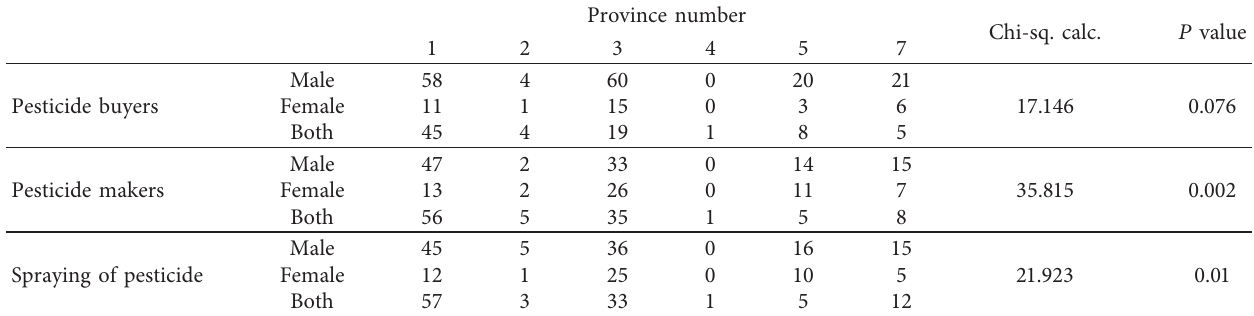
Table 5: Gender role in pesticide handling in different study areas. Province number